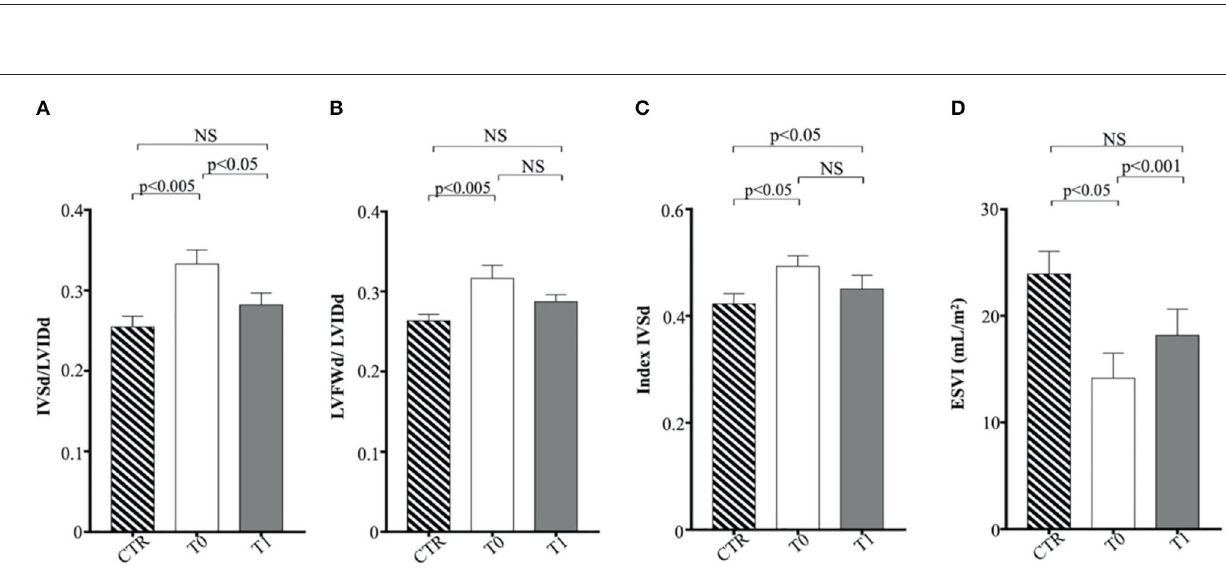
FIGURE 5 | Echocardiographic parameters in enrolled dogs. (A) IVSd/LVIDd, ratio of interventricular septal thickness to left ventricular internal dimension at end diastole; (B) LFVFWd/LVIDd, ratio of left ventricular free wall thickness to left ventricular internal dimension at end diastole; (C) indexed IVSd, indexed interventricular septum thickness at end diastole; (D) ESVI, end-systolic volume index. Control (CTR) group, dashed column; obese dogs at T0, white column; obese dogs at T1, gray column. Statistics: Wilcoxon matched-pairs signed-rank test was used for T0 and T1 comparation in obese dogs, while Mann–Whitney test was performed for the comparation between T0 obese dogs and CTR subjects. NS means not significant